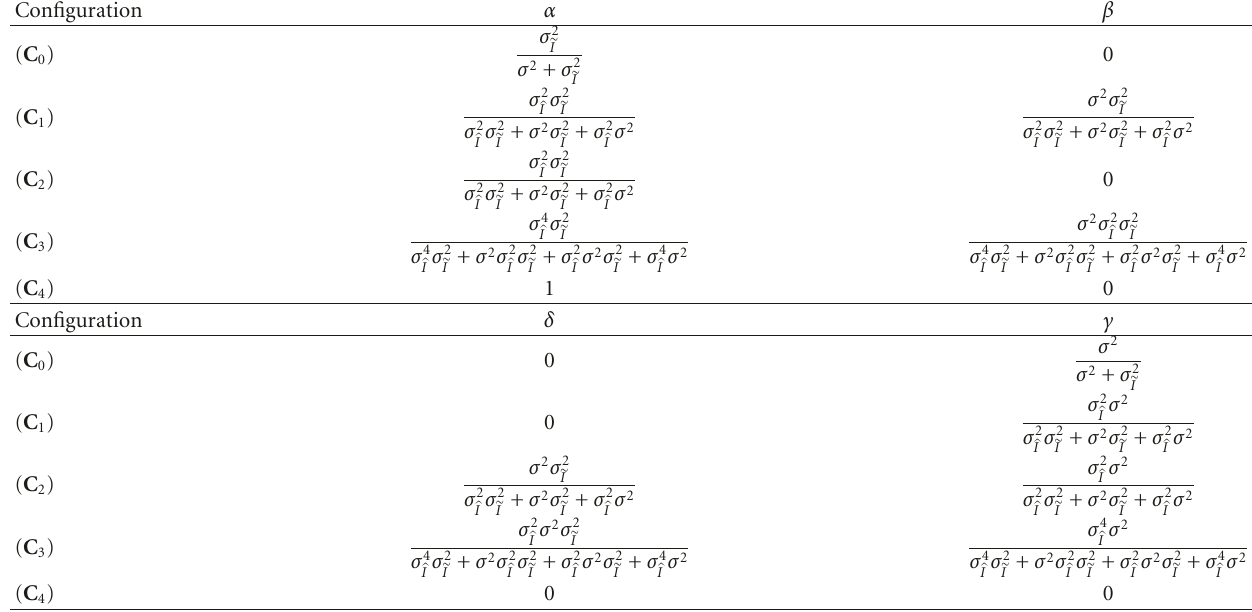
and the one of the predicted image σ (cid:15) I